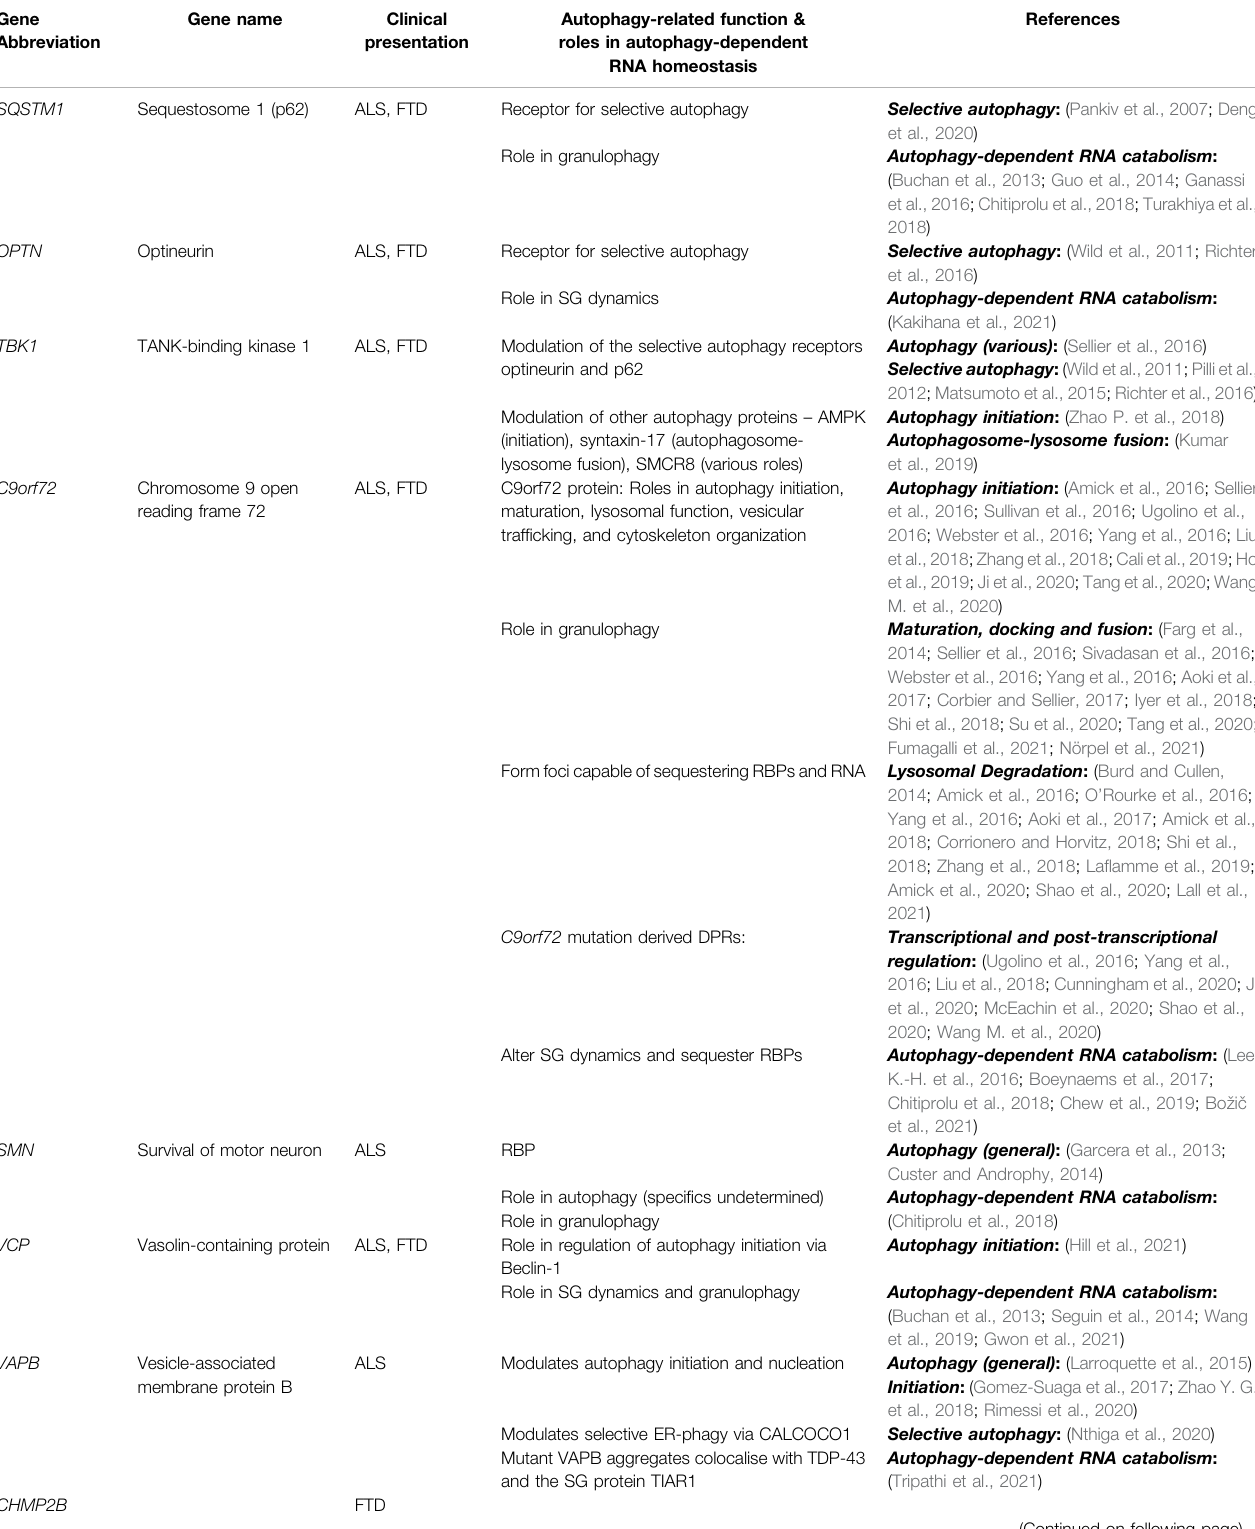
TABLE 1 | Autophagy-related ALS/FTD genes and their putative direct or indirect functions in dysfunctional autophagy-RNA homeostasis